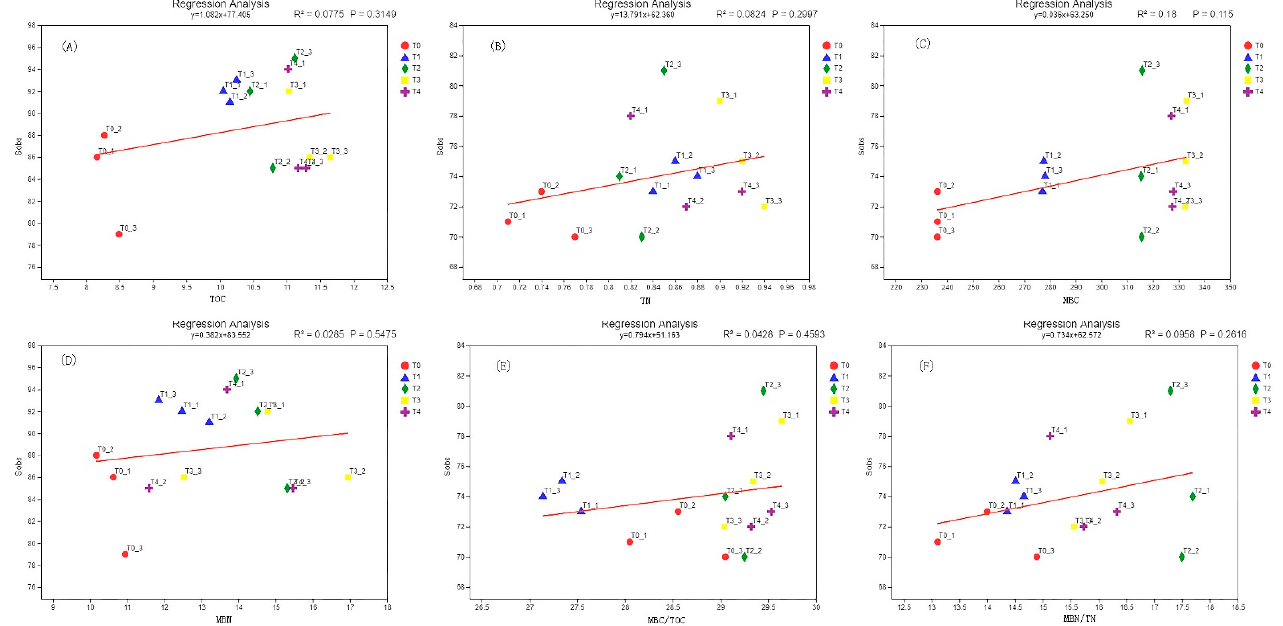
Figure 7. Regression analysis of fungal ordination. ( A ) The environmental factor is total organic carbon (TOC); ( B ) the environmental factor is microbial biomass carbon (MBC); ( C ) the environmental factor is TN (total nitrogen); ( D ) the environmental factor is microbial biomass nitrogen (MBN). ( E ) the environmental factor is MBC/TOC. ( F ) the environmental factor is